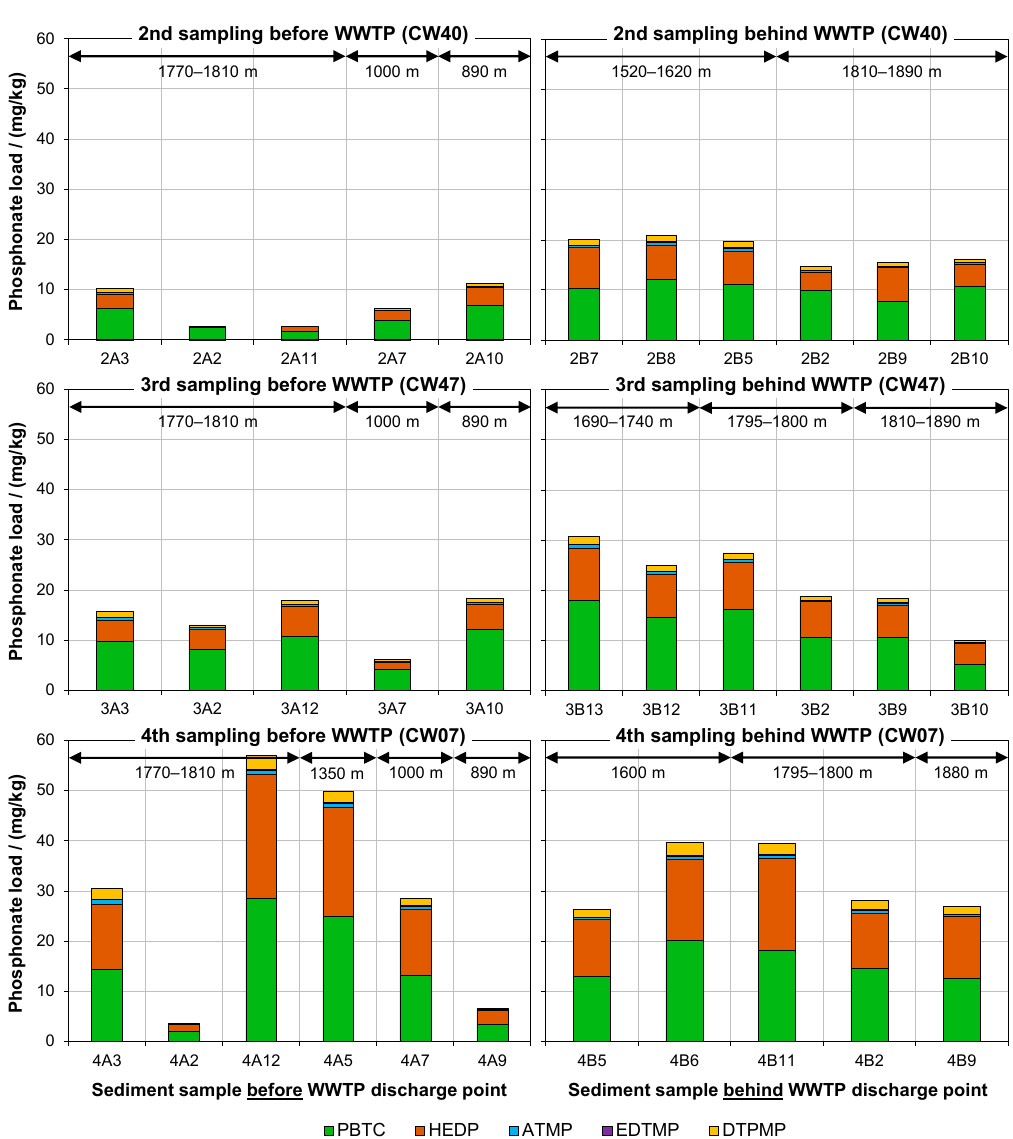
Figure A5. Phosphonate loads on sediment samples from the second (CW40), third (CW47), and fourth (CW07) sampling, which were taken at different points in River1 and analyzed individually (meters indicate the distance to the WWD; key “2A1” or “2B1”: 2: second sampling, A/B: before/behind the WWD, 1: sediment location).